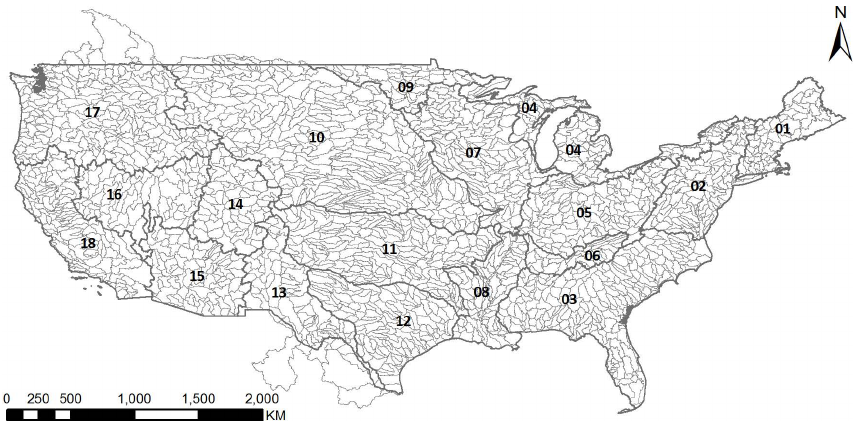
Fig. 2. Study area in this study. The smaller polygons represent the hydrologic subbasins (HUC8) and the larger polygons with thicker grey boundaries represent the hydrologic regions (HUC2). The 2-digit numbers represent the HUC2